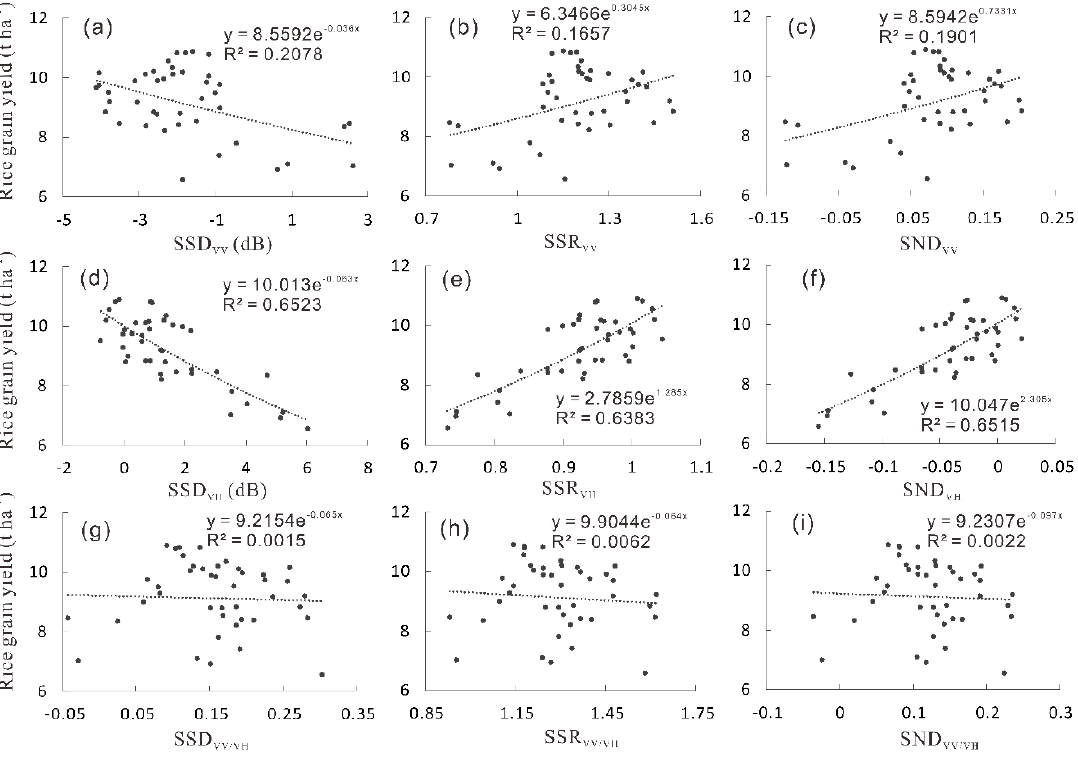
Figure 4. Scatter plots of SAR indices combining both growth stages (x-axis) and grain yield (y-axis). ( a ) SSD VV , ( b ) SSR VV , ( c ) SND VV , ( d ) SSD VH , ( e ) SSR VH , ( f ) SND VH , ( g ) SSD VV / VH , ( h ) SSR VV / VH , ( i ) SND VV / VH .